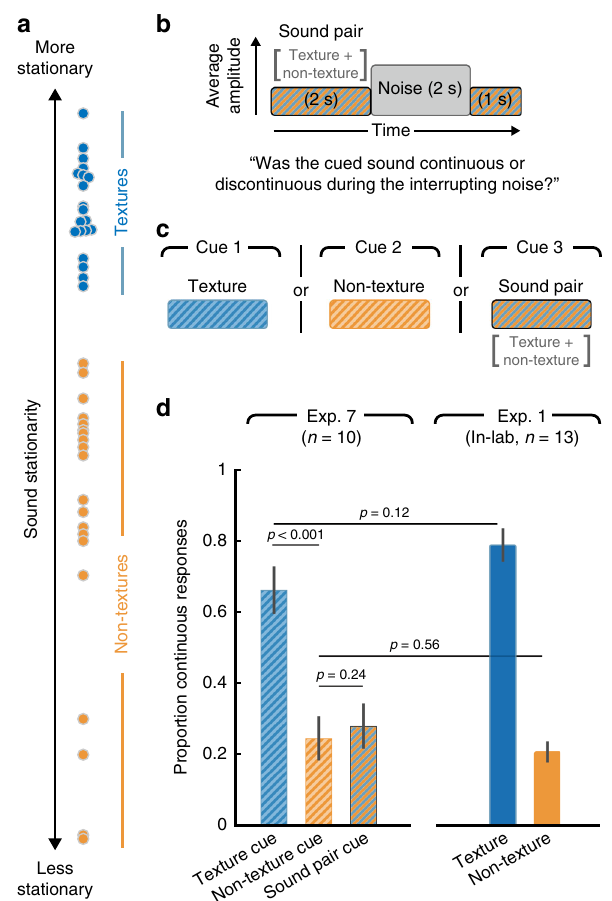
Fig. 8 Experiment 7 — illusory continuity in auditory scenes. a Stationarity of the 40 real-world sound recordings used as inducers in Experiment 7. The sounds were divided into two groups: 20 textures and 20 non-textures (selected based on their sound stationarity). b Schematic of the main stimulus conditions in Experiment 7. The inducer sound was the superposition of a texture with a non-texture (sound pair), and was interrupted by masking noise as in previous experiments. c A cue sound was presented to the listeners prior to each trial, indicating which sound they should be judging the continuity of. The cue could either be the texture, the non-texture or the superposition of the two. d Results of Experiment 7, plotting the proportion of continuous responses for each of the three conditions. Right bars: The results of the same task for the 20 textures and 20 non-textures presented in isolation, replotted from Experiment 1. Error bars show